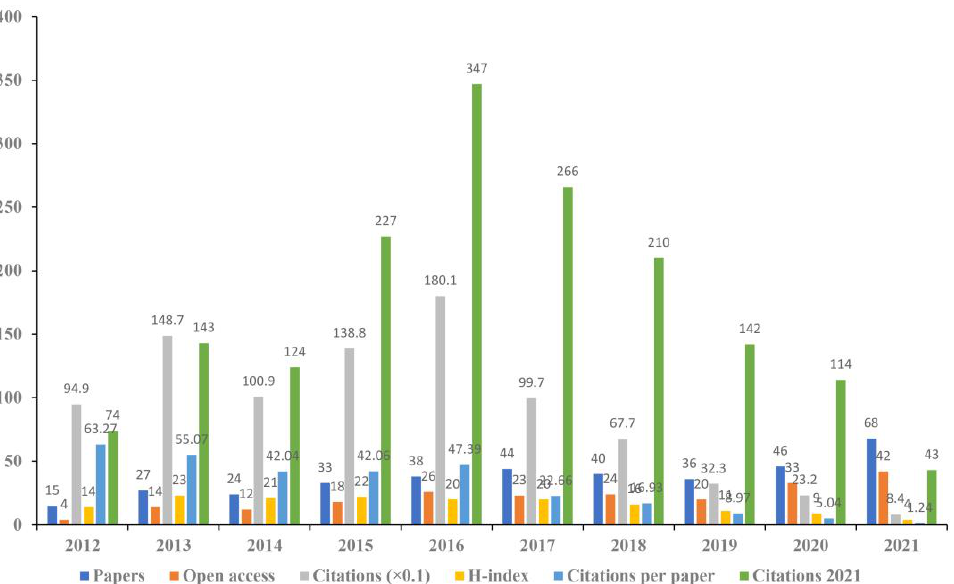
Figure 3. The annual number of papers, open access papers, citations ( × 0.1), H-index, citations per paper, and citations in 2021 of included studies.